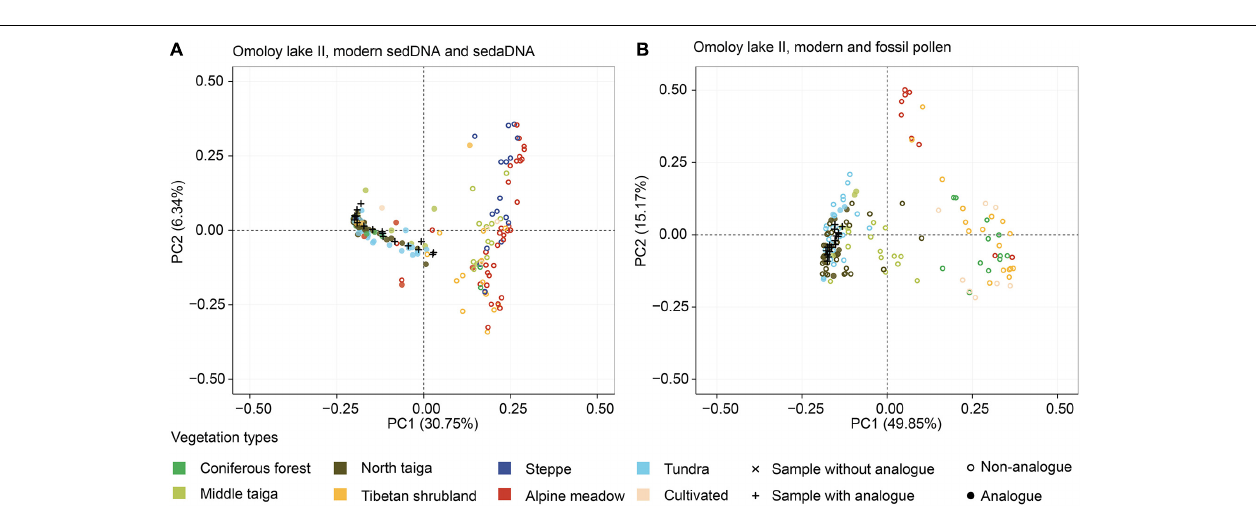
FIGURE 7 | Plots of the principal component analysis (PCA) showing the ordination of fossil assemblages (black) and modern assemblages (coloured according to vegetation type) of Omoloy lake II. PCA site scores explain 37.09 and 65.02% of the total variance of the log-chord transformed sedDNA training-set (A) and modern pollen data (B) , respectively. Both plots suggest that the vegetation composition is mainly similar to those of modern taiga and